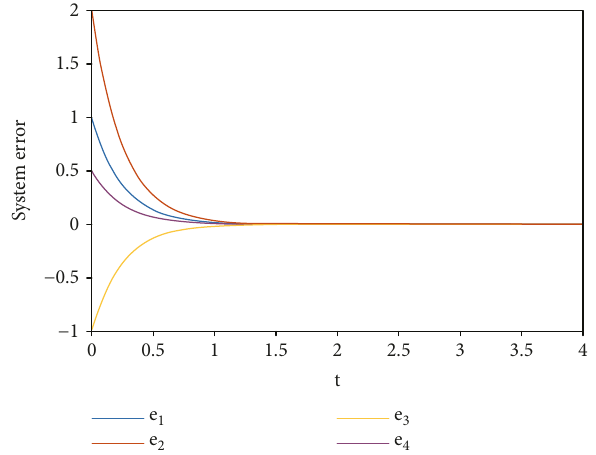
Figure 8: The history of synchronization